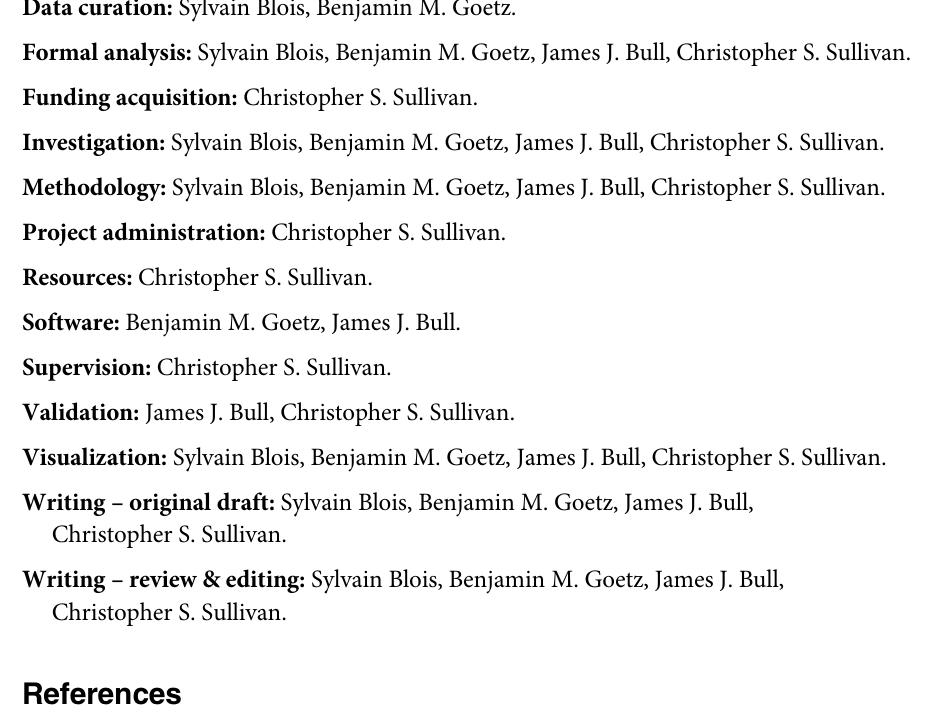
Levenshtein distance parameter; the x-axis panels show the message-passing vs spherical results side-by-side. The bar lengths are the square root-transformed total read count percent- ages. The colored bars represent correctly recalled input barcodes. Gray bars represent the most common erroneous barcodes for each L distance across either algorithm. Here we show the 10-plasmid controls 10P-A, 10P-D, and 10P-G. (TIFF) S6 Fig. Linearity plots of 10-plasmid controls with L3 clustering parameter. The log10 transformed x-axis show the copy number of plasmid inputs, the log10 transformed y-axis rep- resents L3 clustered read counts. Linear regression trendlines are plotted in gray, with corre- sponding R 2 values. Linearity in 10-plasmid controls 10P-B and 10P-F is shown.